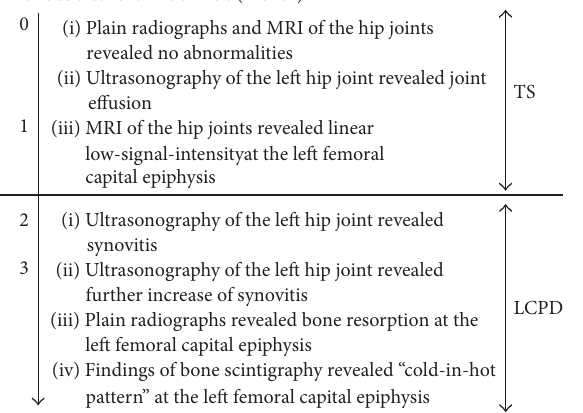
Figure 9: Flowchart of the imaging findings in the present case. MRI: magnetic resonance imaging, TS: transient synovitis, and LCPD: Legg-Calv´e-Perthes